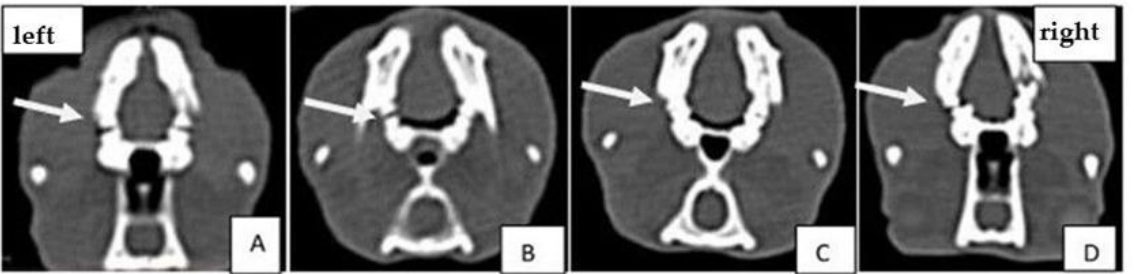
Figure 2. Comparative analysis of CT images of experimental groups on the first day of treatment: ( A ) positive control group; ( B ) aPDT + curcumin group; ( C ) aPDT + oregano group; ( D ) laser therapy group. The arrow indicates the first molar on the left hemimandible where periodontal disease was induced.